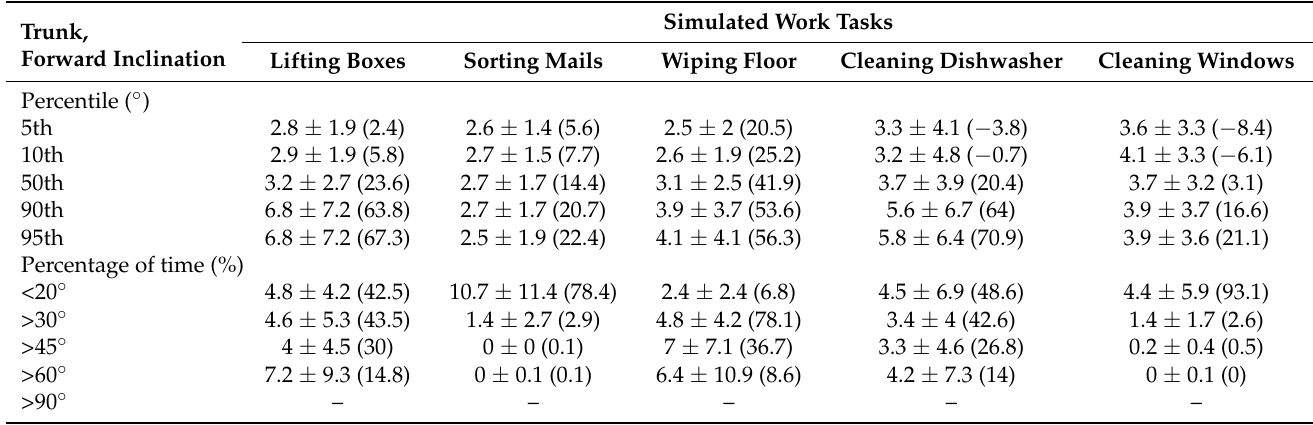
Table 2. The mean ± standard deviation of the mean absolute errors (MAEs) of the trunk forward inclination angle between cloth sensors and skin sensors during the five simulated tasks, with the reference value of skin sensors shown in brackets ( n = 12).